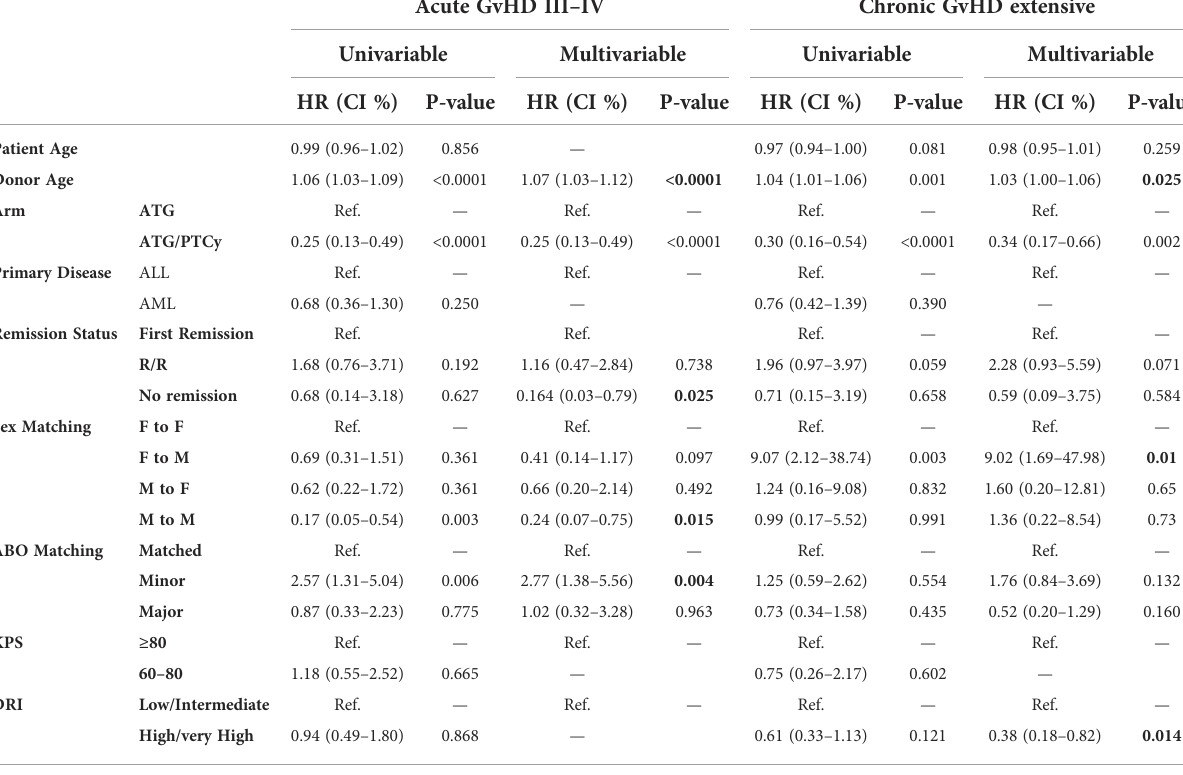
TABLE 2 Univariable and multivariable modeling for grade III – IV acute graft-versus-host disease (GvHD) and extensive chronic